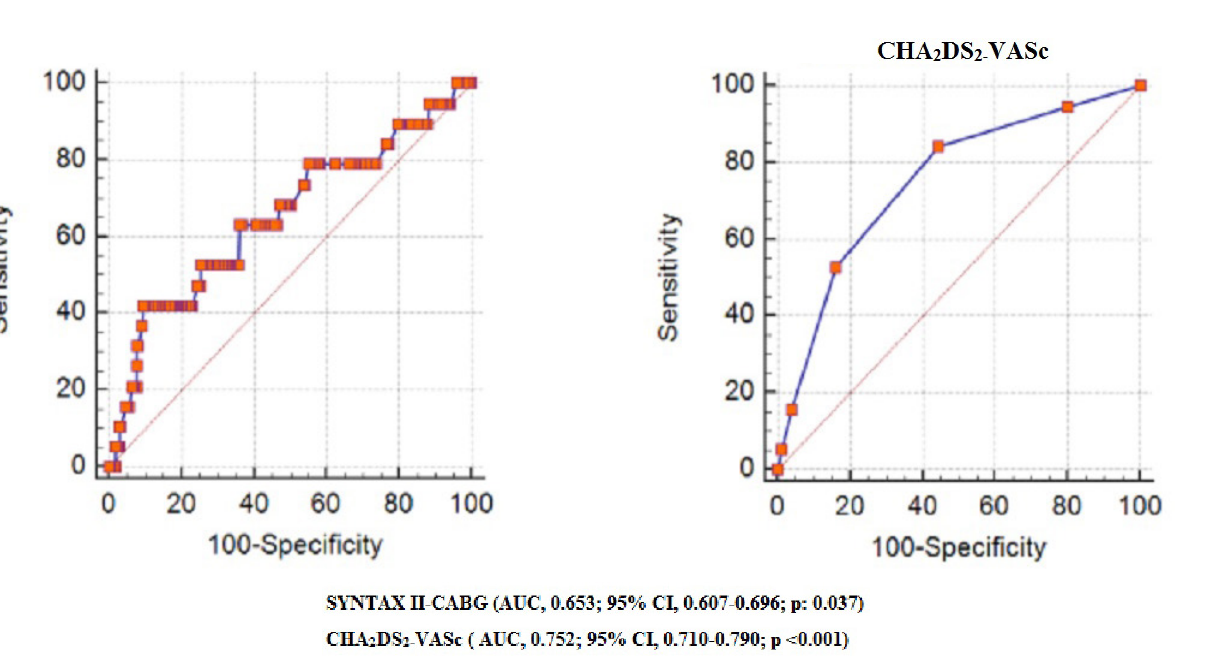
DS -VASc for prediction of a major adverse cardiac event. 2 2